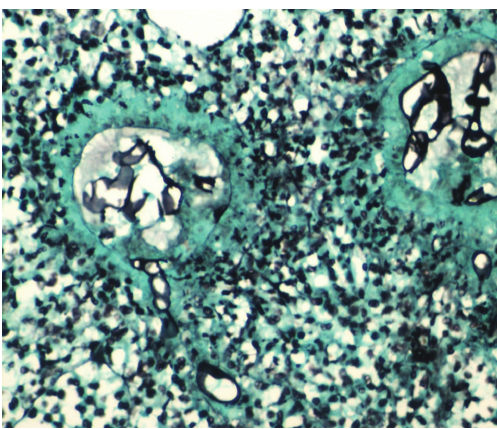
Figure 2: Splendore-Hoeppli bodies surrounded by eosinophils, polymorphs and few histiocytes. (H&E, 400x).